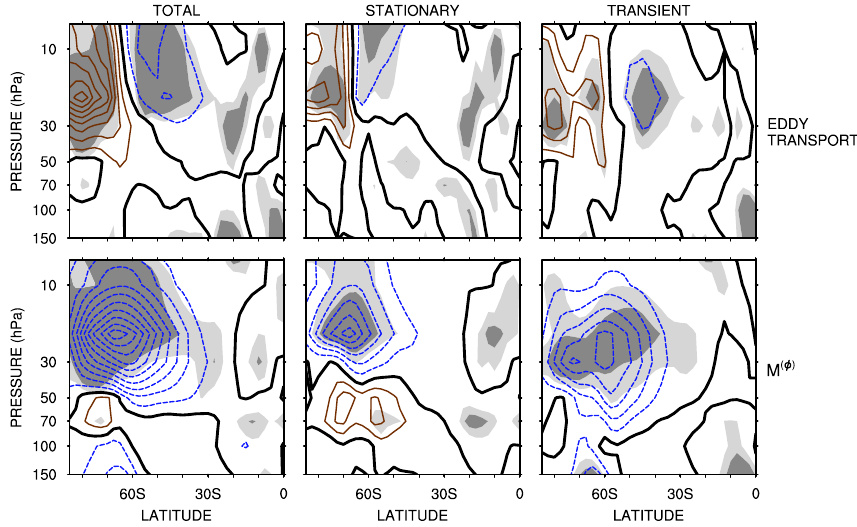
Fig. 8. Same as Fig. 7 but for the eddy ozone transport and the horizontal component of the eddy flux vector, with the contributions of stationary and transient waves. Contour spacing is 10ppbvday − 1 per decade for the eddy transport and 2 × 10 5 kgppbvm − 2 day − 1 per decade for M (φ)